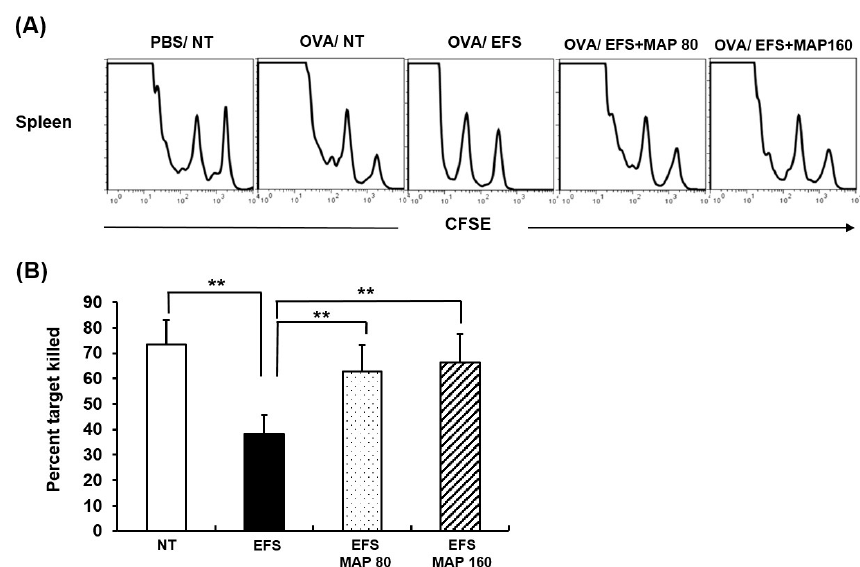
Figure 6. Immune enhancing effect of MAP on activity of cytotoxic T lymphocytes (CTLs) in chronically stressed mice. Mice are grouped as described in Figure 1 and were OVA-immunized. ( A ) Histogram peaks show number of target cells in untreated PBS-immunized group, determined to indicate level of two target cell populations; ( B ) Specific killing (%) of OVA (257–264) peptide-pulsed target cells in the spleen. Ratio of carboxyfluorescein succinimidyl ester (CFSE) high and CFSE low was calculated as a numerical value to present specific killing. Values are means ± SEM of three experiments, n = 5, ** p < 0.01 compared with control.